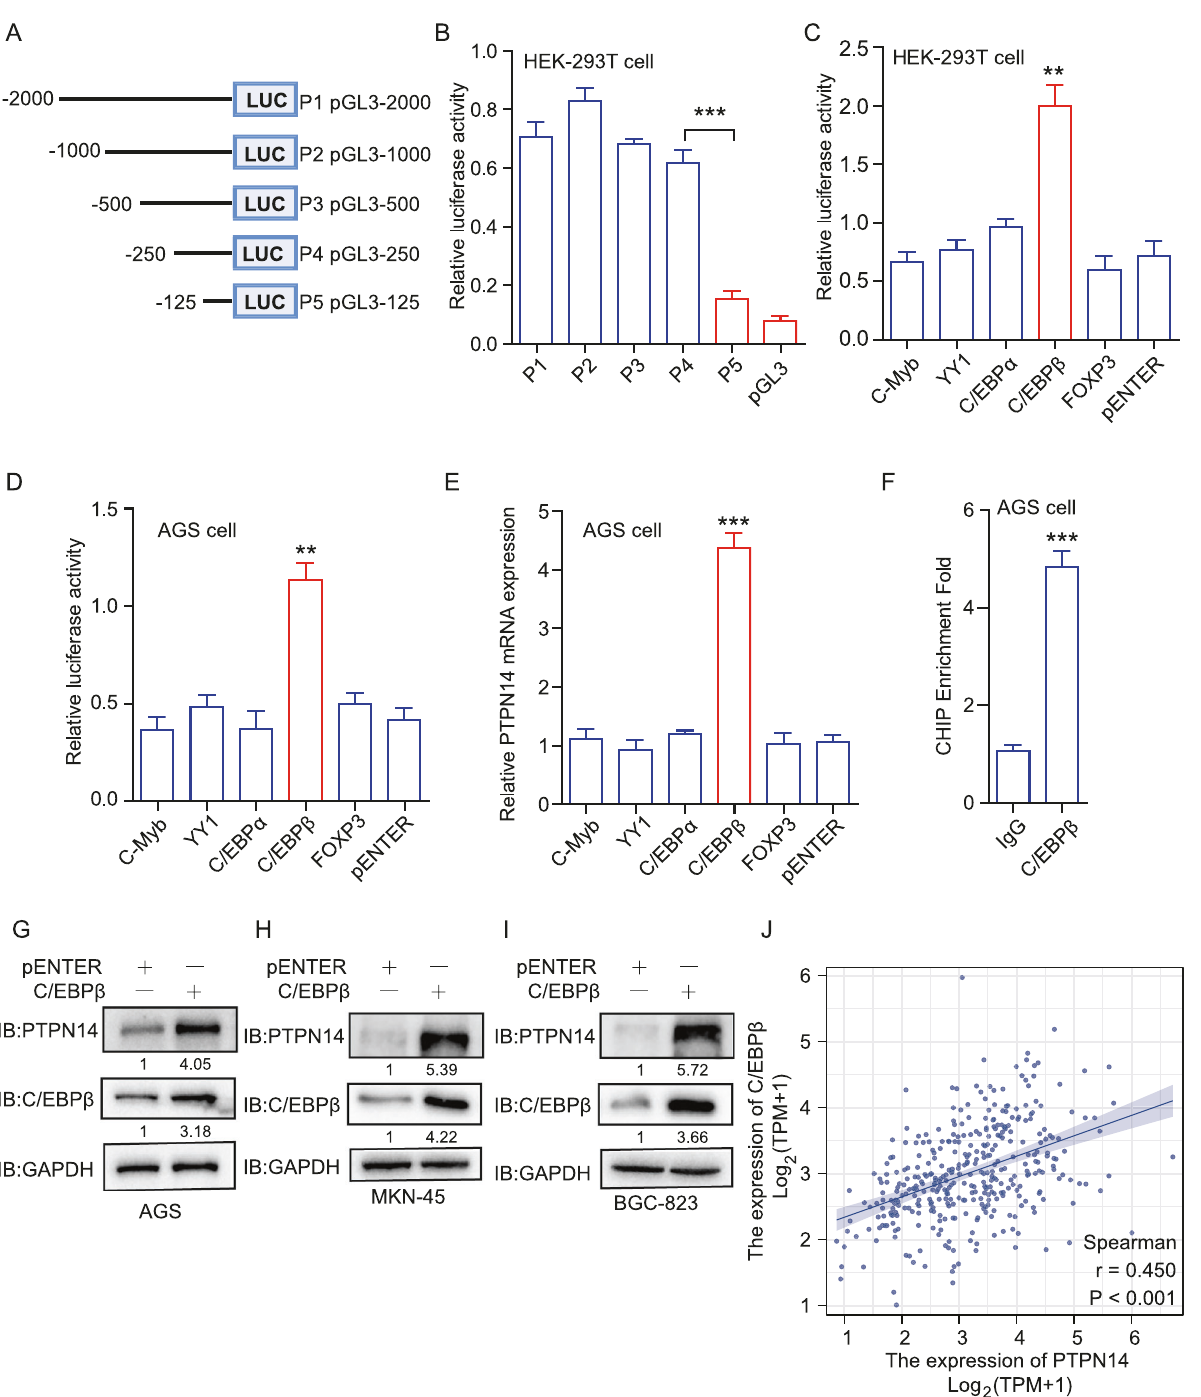
Fig. 2 C/EBP β activates PTPN14 transcription in gastric cancer. A Schematic representation of luciferase vectors pGL3-2000(P1), pGL3- 1000(P2), pGL3-500(P3), pGL3-250(P4) and pGL3-125(P5). B Dual luciferase assay of the PTPN14 promoter fragments in HEK-293T cells indicated that the upstream 125 – 250 bp was the core region for PTPN14 transcription. *** p < 0.005; cells transfected with P5 were compared with cells overexpressing P4. C , D Dual luciferase assay showed that CEBP/ β increased the transcriptional activity in HEK-293 T cells ( C ) and AGS cells ( D ). ** p < 0.01; cells overexpressing CEBP/ β were compared with overexpressing pENTER vector. E RT-qPCR showed that CEBP/ β elevated the mRNA expression level of PTPN14 in AGS cells. *** p < 0.005; cells overexpressing CEBP/ β were compared with overexpressing pENTER vector. F ChIP-qPCR assays illustrated that the promoter regions precipitated by the anti-CEBP/ β antibody were much more enriched than the anti-IgG antibody. *** p < 0.005; promoter regions were precipitated by anti-CEBP/ β antibody were compared with anti-IgG antibody. G – I Western blot showed that CEBP/ β promoted PTPN14 expression remarkably in AGS cells ( G ), MKN-45 cells ( H ), and BGC-823 cells ( I ). J Correlation analysis of PTPN14 expression and CEBP/ β expression in gastric cancer from TCGA